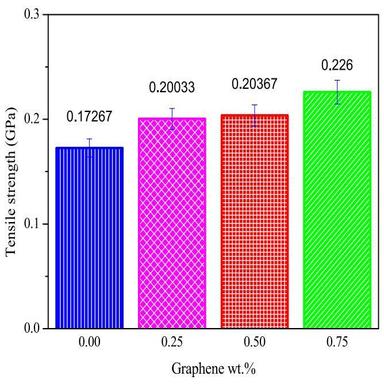
Tensile strength for GFRP composites with various wt% of graphene.